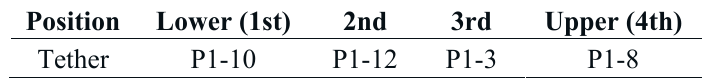
Table 3. The tethers deployed at SWMTF and their position in the southern limb.